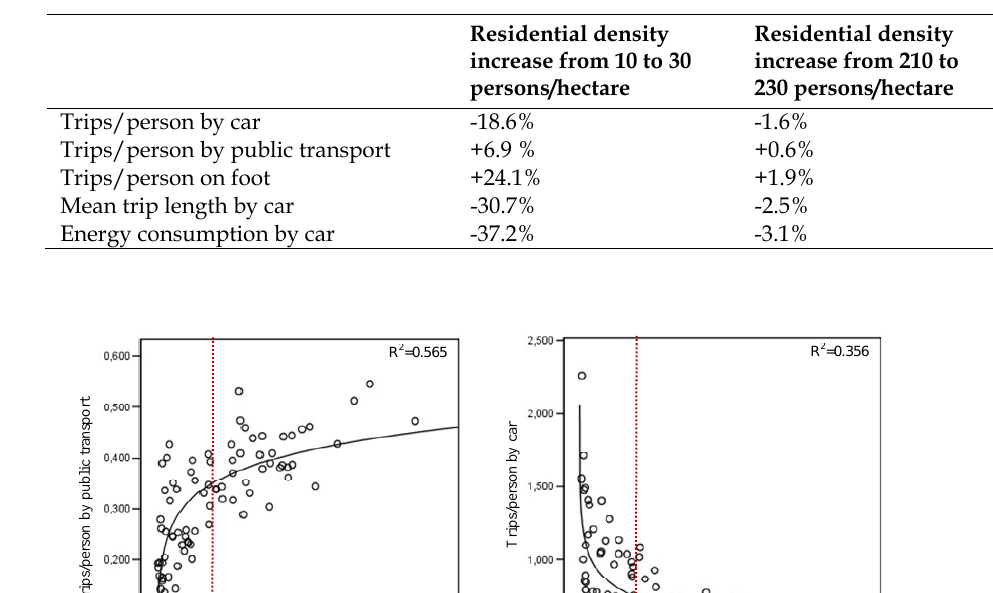
Table 4. The effects of density increases on travel characteristics in two examples